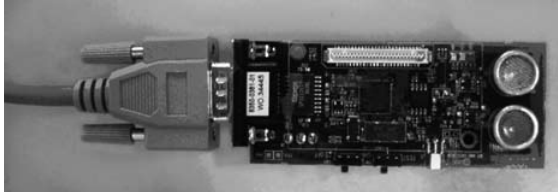
fig. 6. Cricket unit / RS232 cable assembly